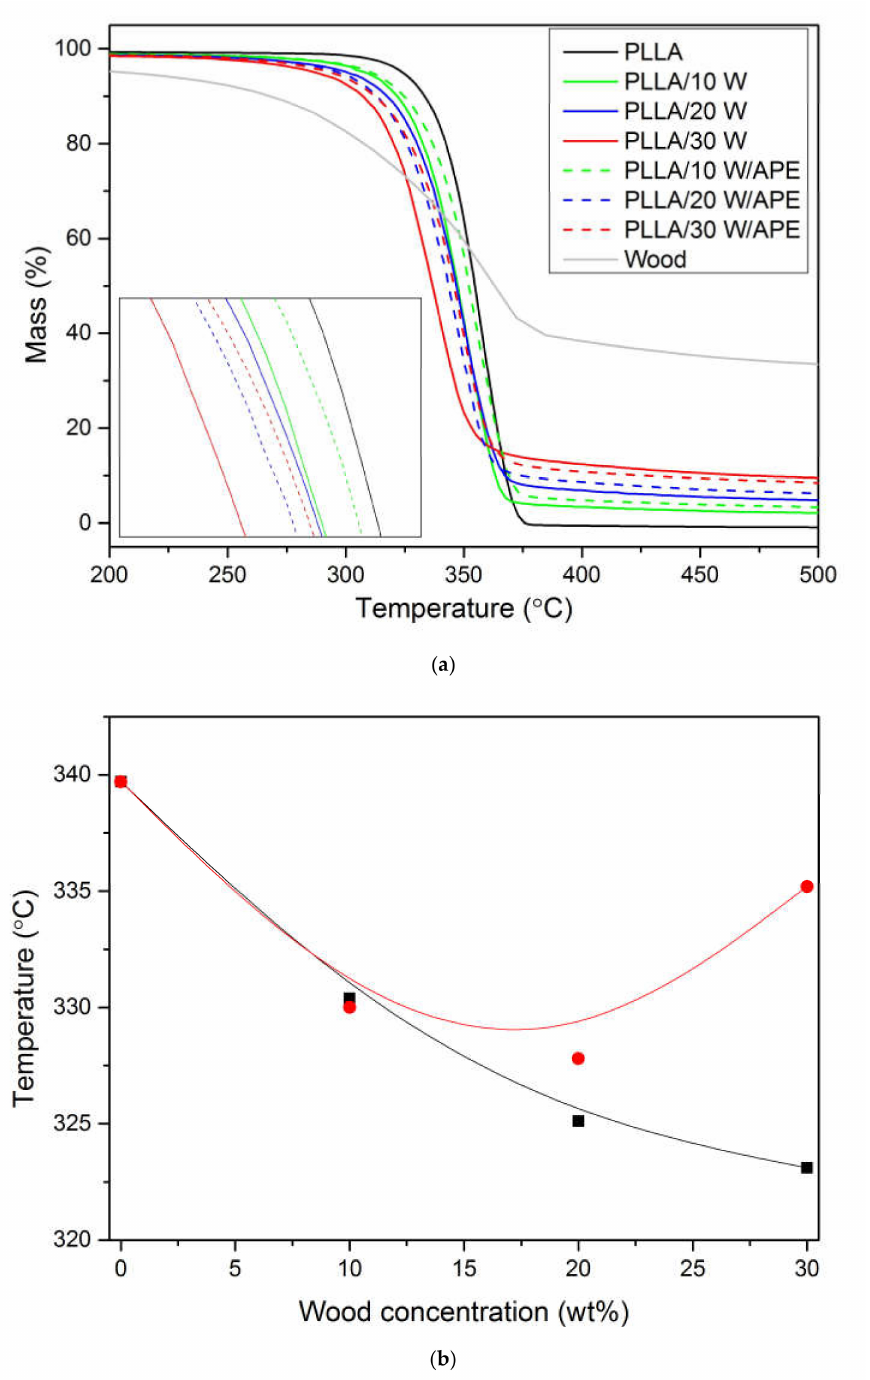
Figure 5. Raw TGA curves ( a ) and onset temperatures ( T o ) of PLA / wood composites in a function of wood concentration ( b ). Symbols: onset temperatures of PLA / wood ( (cid:4) ) and PLA / wood / APE series ( • ). Lines were drawn to guide the